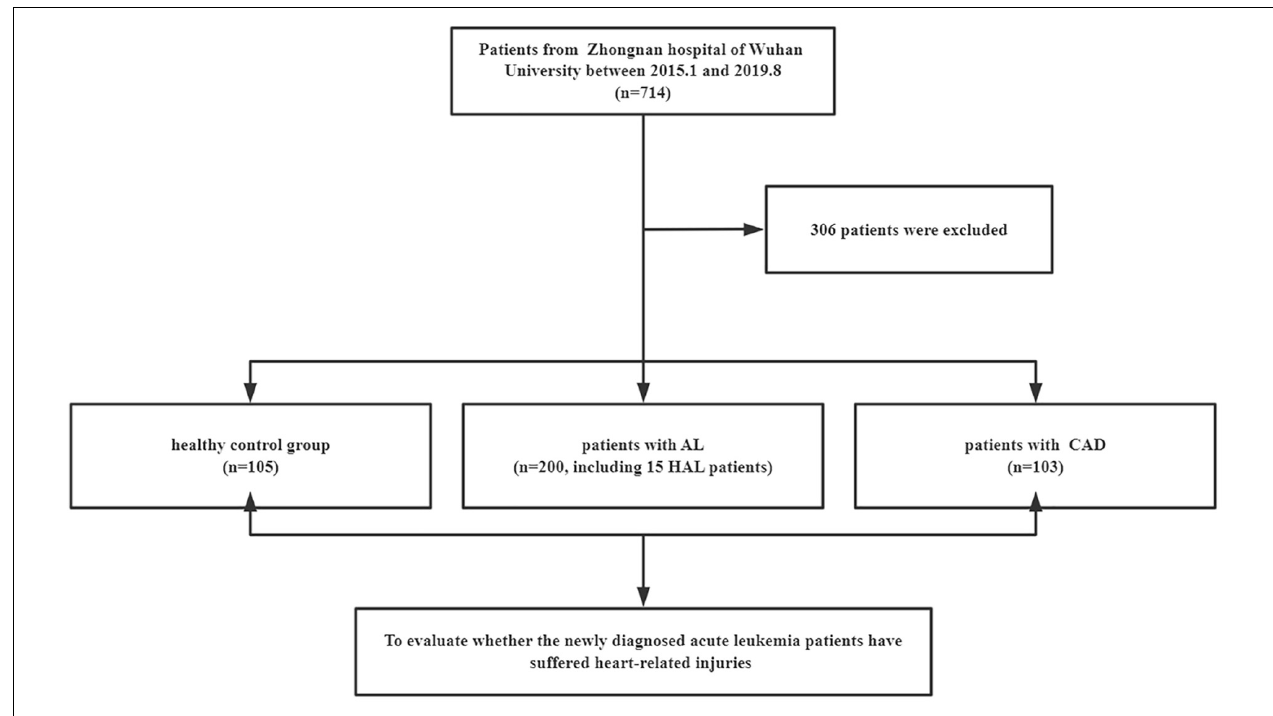
FIGURE 1 | Selection of participants. AL, acute leukemia; CAD, coronary artery disease; HAL, hyperleukocytic acute leukemia.